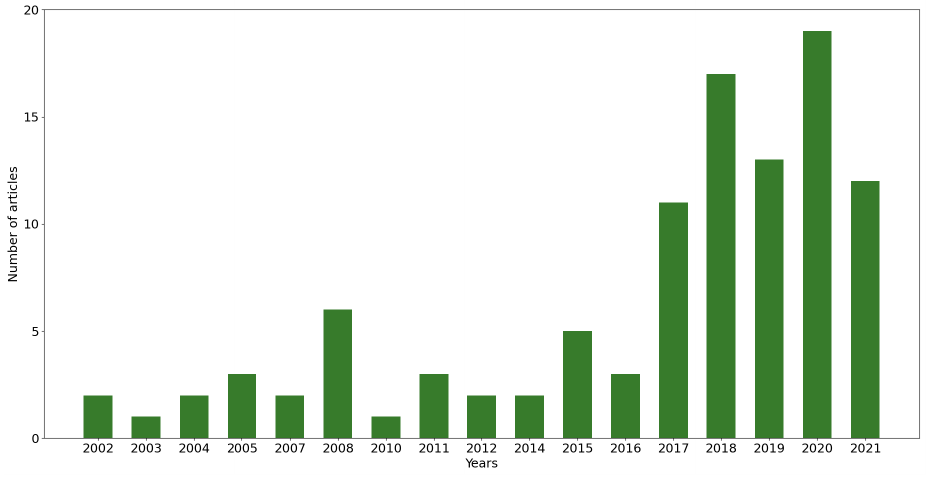
Figure 1. Year distribution of the reviewed articles.